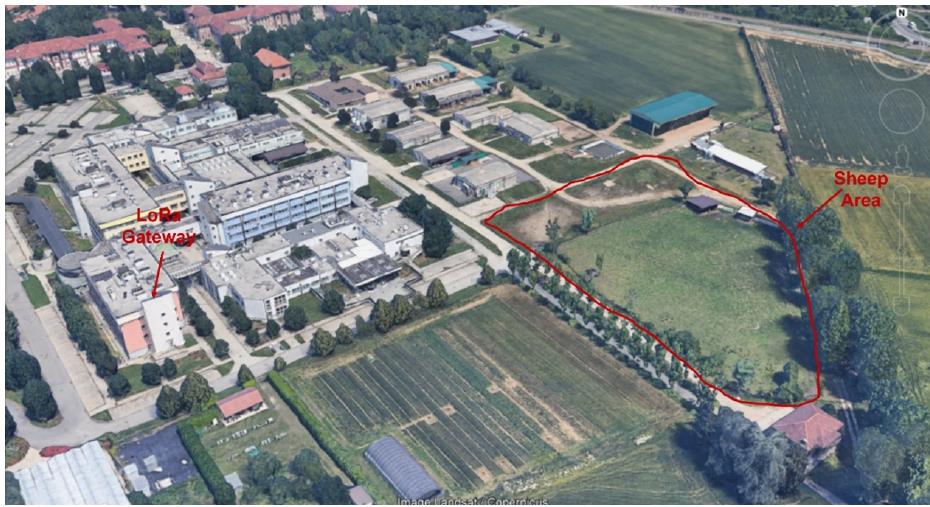
Figure 6. LoRaWAN gateway and the sheep area.